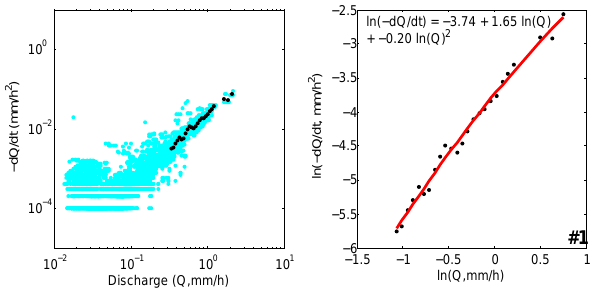
Figure 5. Recession plots for the Ardèche at Meyras (#1) catchment for all low-vegetation periods between 2000 and 2008: left, flow recession rates ( − d Q/ d t ) as a function of flow ( Q ) for individual rainless night hours (blue dots) and their binned averages (black dots); right, quadratic curve fitting with binned